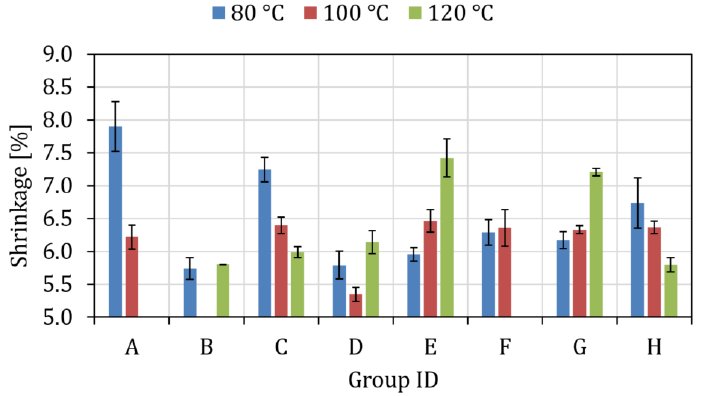
Figure 6. CT Measurement results of volumetric shrinkage (the standard deviations related to two different parts are